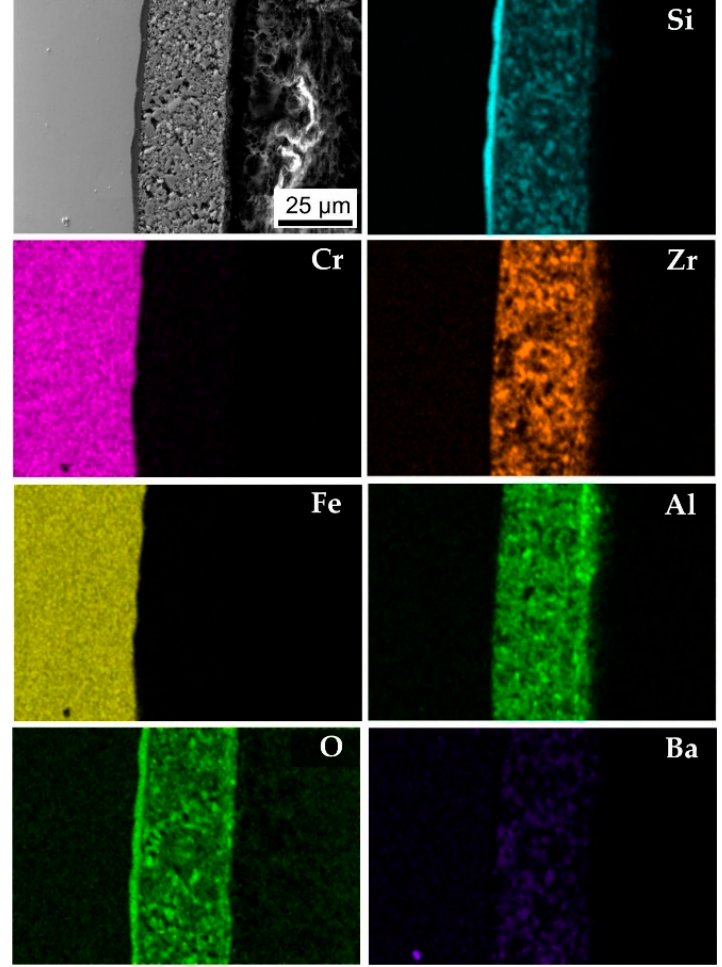
◦ C. Figure 5. SEM/EDXS analysis of composition D4 after pyrolysis at 850 °C. Figure 5. SEM/EDXS analysis of composition D4 after pyrolysis at 850 Figure 7 shows the SEM micrographs of the selected coatings after oxidation tests in synthetic air. Compared to the coatings after pyrolysis (Figure 4), a significant increase in the porosity of the layers and in the pores size can be observed. The dark gray areas in the cross-sectional SEM images, indicated by the yellow arrows, were identified by EDXS analysis as residual porosity, with the pores filled with synthetic resin used for embedding of samples during the preparation of cross-sections. The expansion of the existing pores is attributed to used glass frits softening and the subsequent differential sintering of individual components in the layers by viscous flow and complemented by crystallization of phases from residual glass (celsian, hexacelsian). At 900 ◦ C (Figure 7), the C2c coating showed good adhesion to the metal substrate, with the occasional occurrence of cracks at the metal–coating interface. However, further expansion of the pores and increased frequency of cracking between the steel substrate and the coating was observed at higher temperatures, which eventually led to a gradual delamination of the